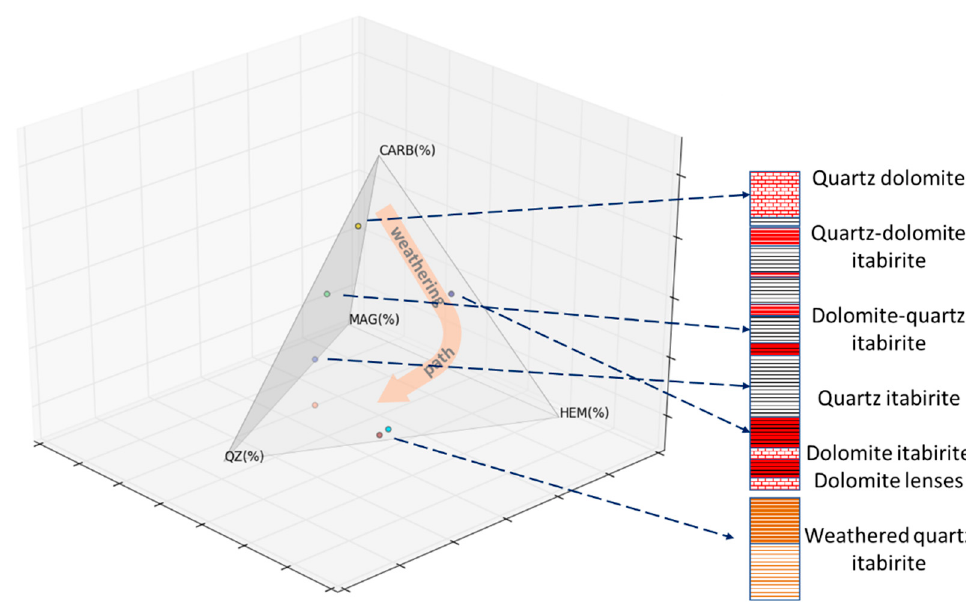
Figure 13. Tetrahedron of relative proportions of hematite, carbonates, magnetite and quartz (vol. %) showing fresh and weathered lithotypes and their position in the proposed depositional sequence. Each vertex represents 100% of the mineral variable indicated there. A given point inside the tetrahedron has components that are proportional to how close the point is to the corresponding vertex.